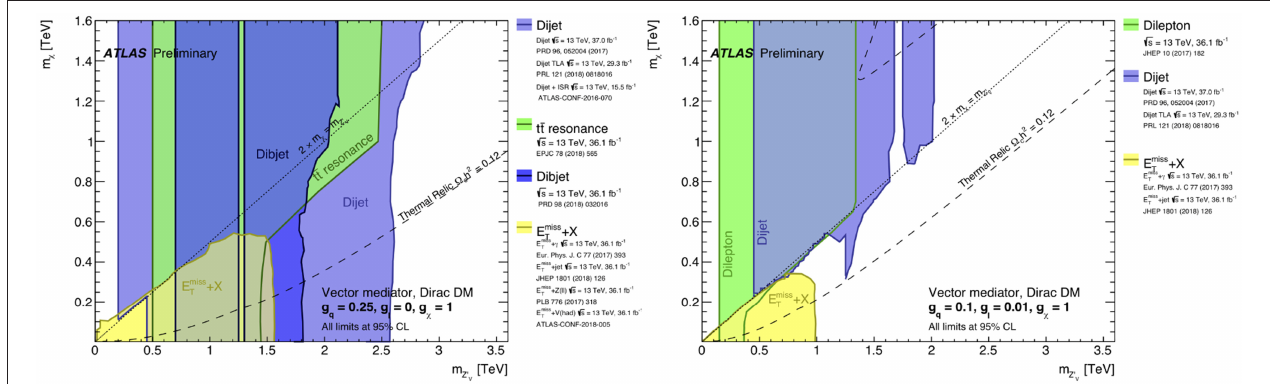
FIGURE 2 | Regions in a DM mass-mediator mass plane excluded at 95% CL by the ATLAS dijet, dilepton and mono-X searches, for vector mediator simplified models with two choices of the couplings: leptophobic scenario (Left) and leptophilic scenario (Right). Exclusions are computed for the DM coupling g χ , the quark coupling q g , universal to all flavors, and the lepton coupling q l , indicated in each plot. The dashed curve “thermal relic" indicates combinations of DM and mediator mass that are consistent with a DM density of (cid:127) 0.12 h 2 and a standard thermal history. A dotted curve indicates the kinematic threshold where the mediator can = decay on-shell into DM. Excluded regions that are in tension with the perturbative unitary considerations are indicated by shading in the upper left corner.